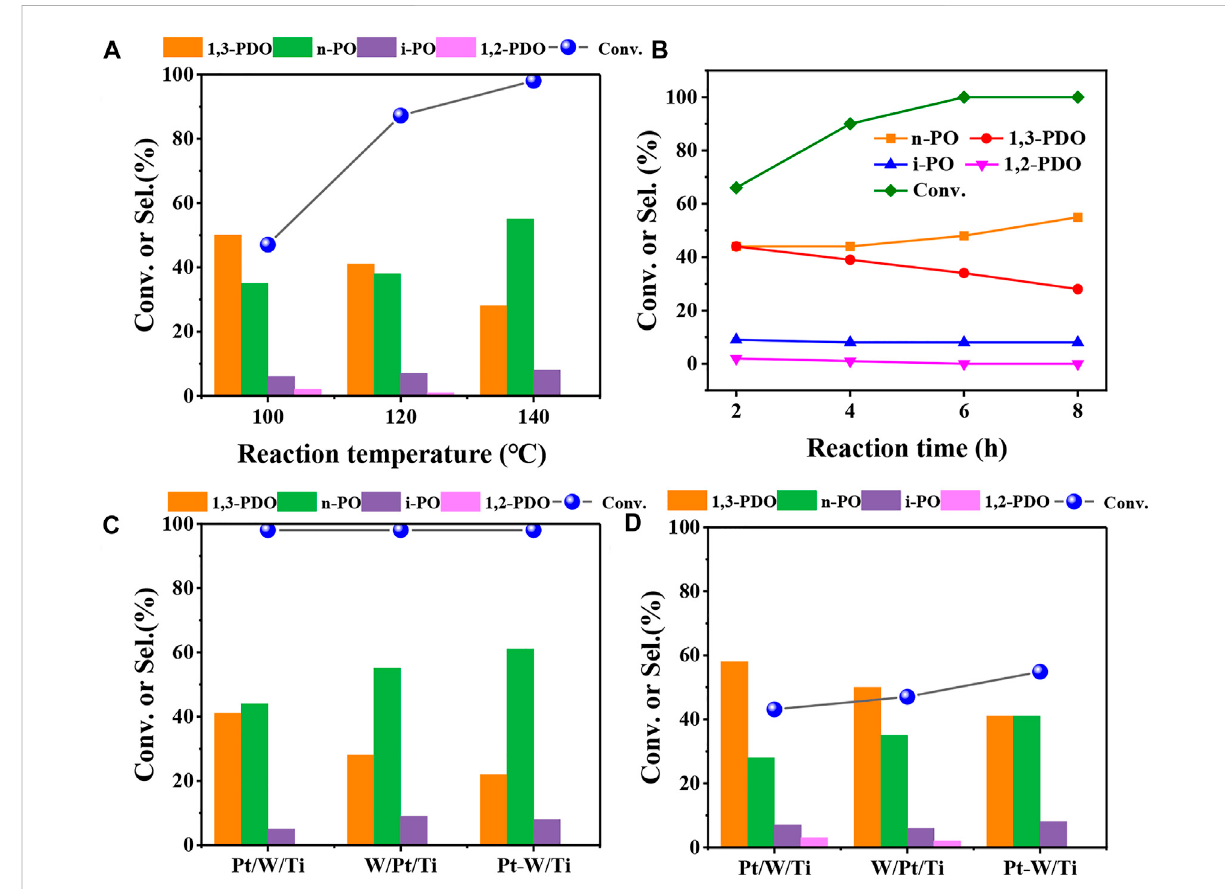
FIGURE 1 Catalytic results of glycerol hydrogenolysis at different reaction temperature (A) and different reaction time (B) over 5W/Pt/A-Ti catalyst; Catalytic results of glycerol hydrogenolysis over different catalysts at 140 ° C (C) and 100 ° C (D) . Reaction conditions: 0.3 g of catalyst (Support: A-Ti, WO x :5wt%)and 4.0 g of10 wt%glycerolaqueoussolution, 6 MPa H 2 , (B,C) 140 ° C,6 h(Pt/W/Timeansthat Wwasloaded fi rst,W/Pt/Ti meansthatPt was loaded fi rst and Pt-W/Ti means that Pt and W were loaded